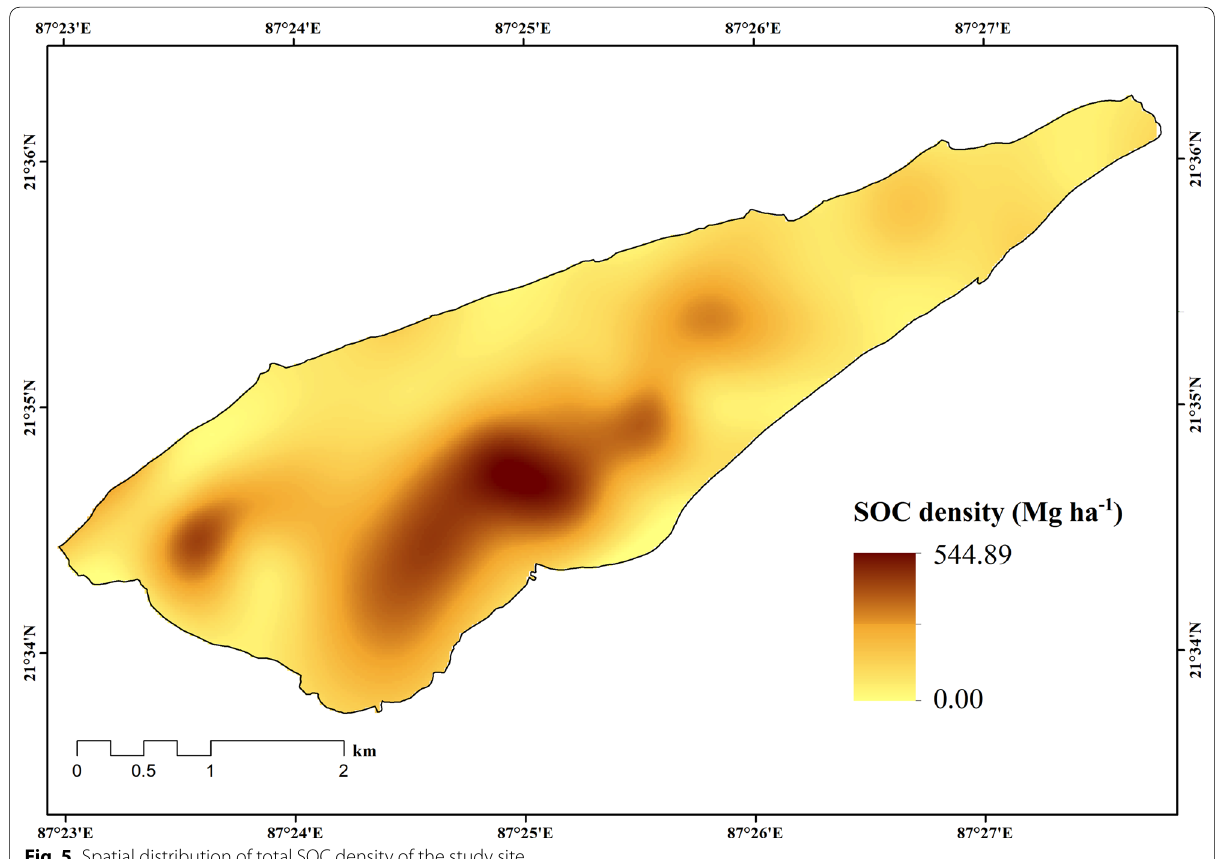
Fig. 5 Spatial distribution of total SOC density of the study